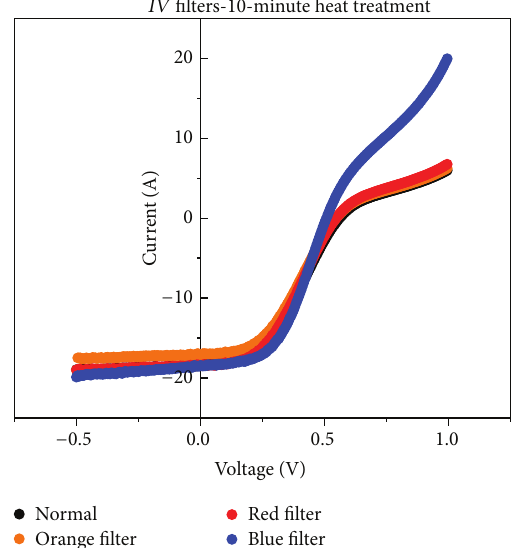
Figure 7: IV curve measurements under filters with a different color of the solar cells heated till 300 ∘ C for 600